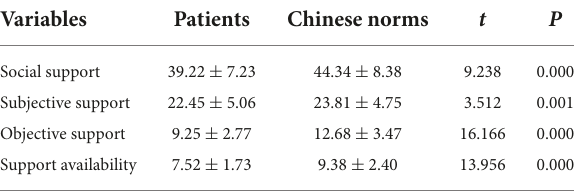
TABLE 3 Comparison between social support scores in patients with vitiligo and Chinese norms (mean ± SD).